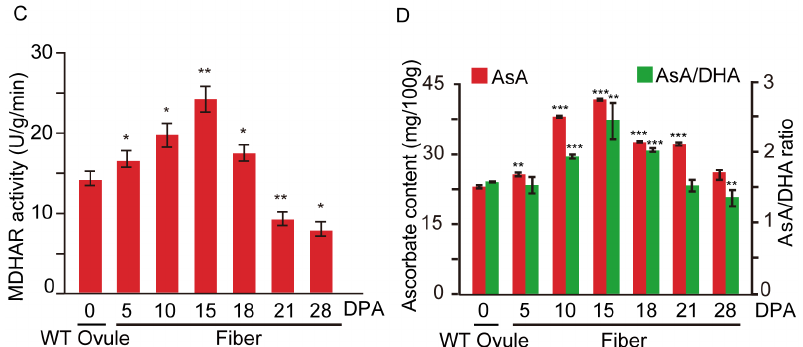
Figure 4. Tissue-specific and fiber-developmental expression analyses of G. hirsutum GhMDHARs . ( A ) Heatmap of expression levels of GhMDHAR genes in different tissues. The fragments per kilobase of exon per million reads mapped (FPKM) values in different tissues including root, stem, leaf, petal, stamen, pistil, ovule and fiber were obtained from the public transcriptomic data released at the website of NCBI and used to generate the heatmap. The colors of blue, yellow, and red indicate the low, moderate and high expression levels respectively. ( B ) qRT-PCR-based heatmap of expression levels of GhMDHAR genes during fiber developmental stages. The 0-DPA ovules and fibers at different stages of 5, 10, 15, 18, 21 and 28 DPA, were collected and used for RNA extract to perform the qRT-PCR assay to analyze the expression levels of GhMDHAR genes. GhUBQ7 gene was utilized as the internal control for normalization. The expression level of 0-DPA ovule was artificially set to 1. The different color scale indicates the gene expression levels with the colors of yellow, orange, and red to present regular, moderate, and high expression abundances respectively. ( C ) MDHAR enzyme activity measurement during fiber development stages. The wild-type 0-DPA ovules and fibers at the stages of 5, 10, 15, 18, 21 and 28 DPA were collected for MDHAR enzyme activity analysis. The value of 0-DPA ovule was utilized as reference for statistical difference analysis through one-way ANOVA, with *, **, and *** to indicate the differences at 0.05, 0.01 and 0.001 levels, respectively. ( D ) AsA content and AsA/DHA ratio determinations during different fiber development stages. The materials of 0-DPA ovule and fibers at different development stages of 5, 10, 15, 18, 21 and 28 DPA were obtained for AsA content determination and AsA/DHA ratio calculation. The value of 0-DPA ovule was used as reference for statistical difference by One-way ANOVA. Asterisks indicate the significant differences, ** p < 0.01, *** p <